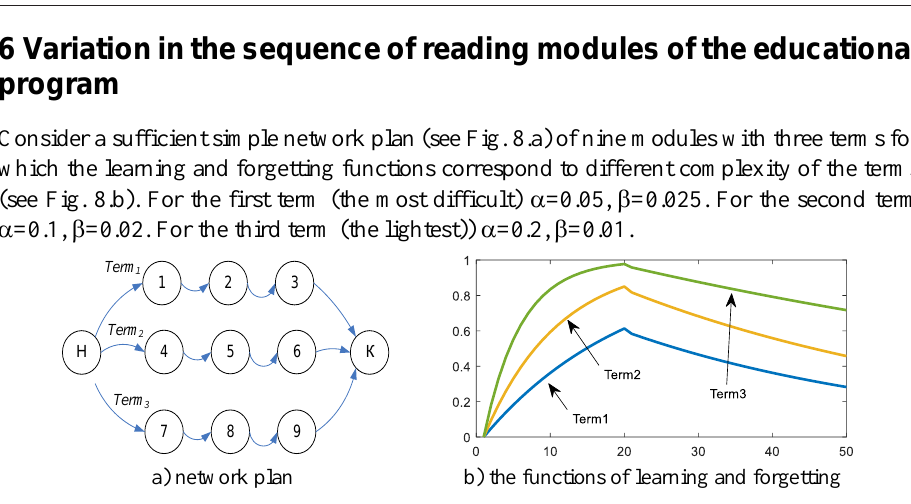
Fig. 8. Learning-forgetting functions for different sequence of reading modules.